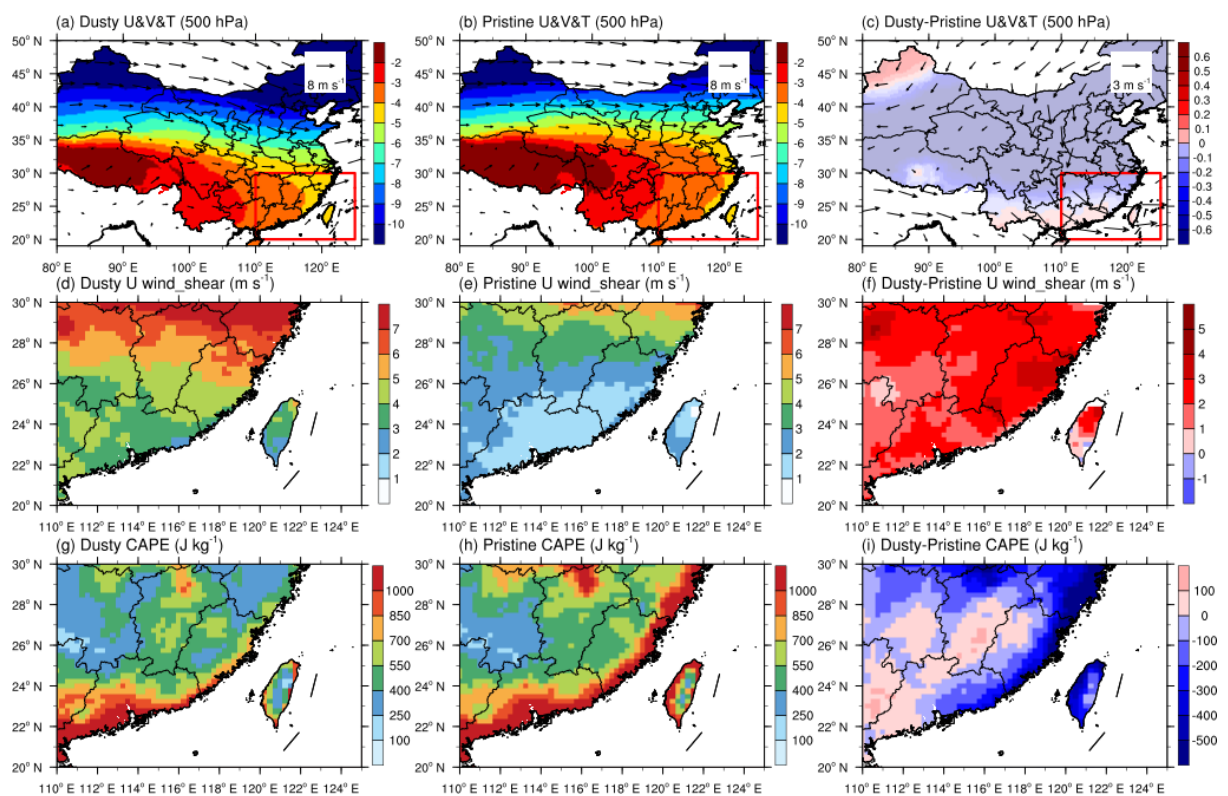
Figure 3. The fields of wind and temperature at 500hPa (a, b, c) , the U wind shear (d, e, f) , and the CAPE (g, h, i) averaged from 46 selected dusty days (a, d, g) and 92 selected pristine days (b, e, h) in JJA during the 2000–2013 period, based on ERA5 reanalysis data at a 0.25 ◦ × 0.25 ◦ horizontal resolution; panels (c) , (f) , and (i) show the associated differences (dusty minus pristine) between the two conditions for each